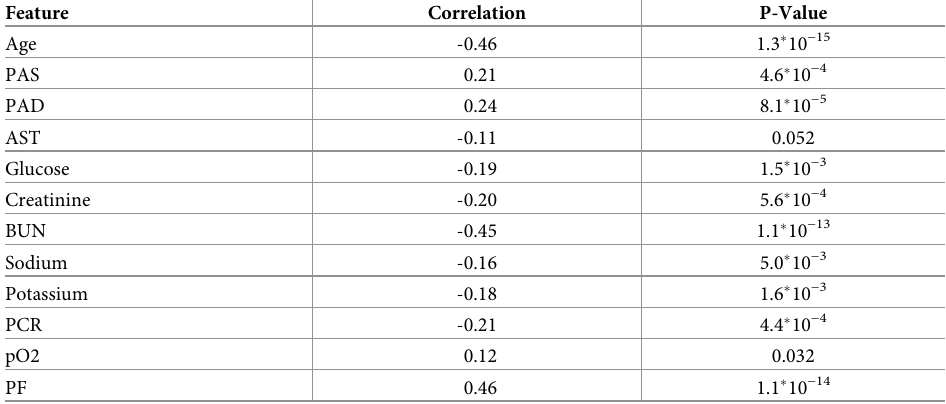
Table 3. Results of the bivariate statistical analysis for continuous variables. Point-biserial correlation values and significance tests between the continuous variables present in Fig 3 and the